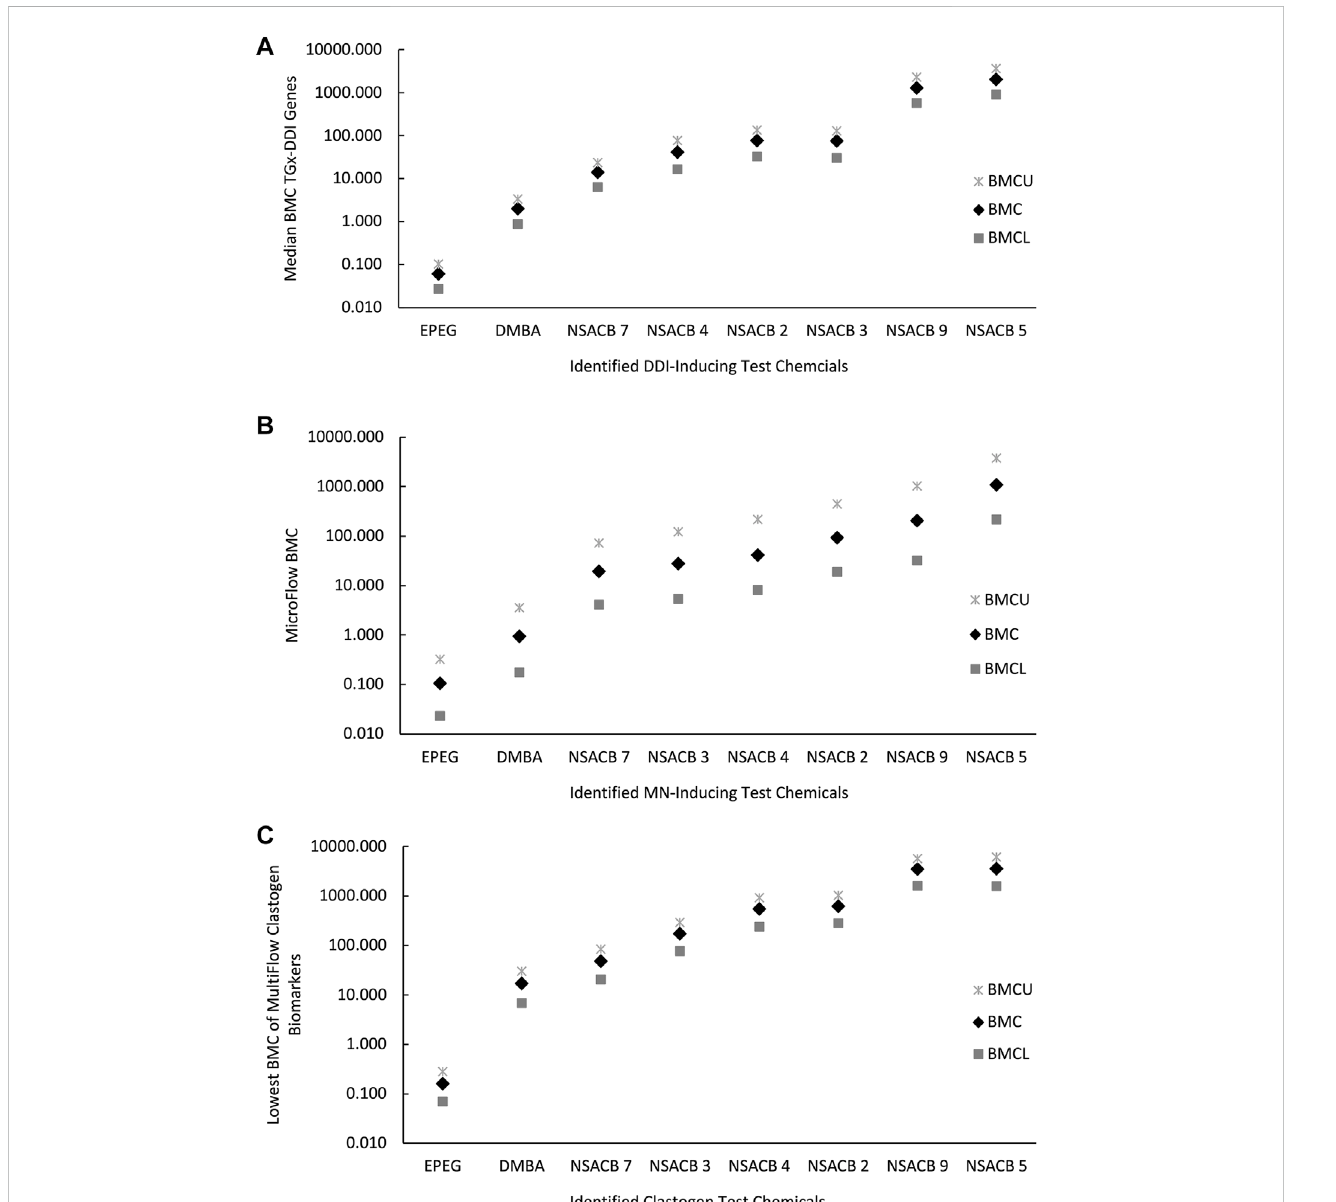
FIGURE 4 Comparison of potency rankings derived from each assay based on the respective Benchmark Concentrations (BMCs) for the NSACB compounds with concordant positive hazard fl ags. (A) The potency ranking from theTGx-DDI transcriptomic biomarker based on thebootstrapped median gene BMC, (B) the rankingfromthe invitro MicroFlow ® assay,and (C) thepotencyranking fromMultiFlow ® assaybasedon thelowest clastogen biomarker BMC.The BMCU and BMCL represent the upper and lower 95% con fi dence limits of the BMC,